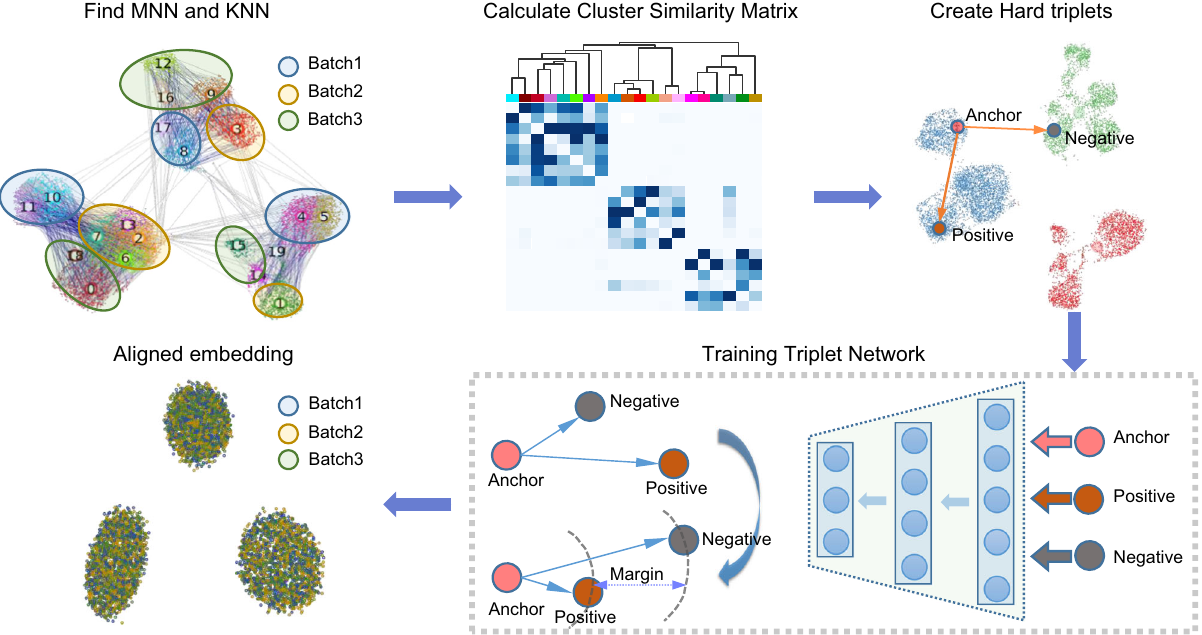
Fig. 1 | Overview of scDML for merging clusters and removing batch effects in scRNA-seqdata. MNN means mutualnearest neighborsand KNN means k-nearest neighbors. The procedure of constructing cluster similarity matrix and the devel- oped merge rule aim to preserve the original cluster information, including some